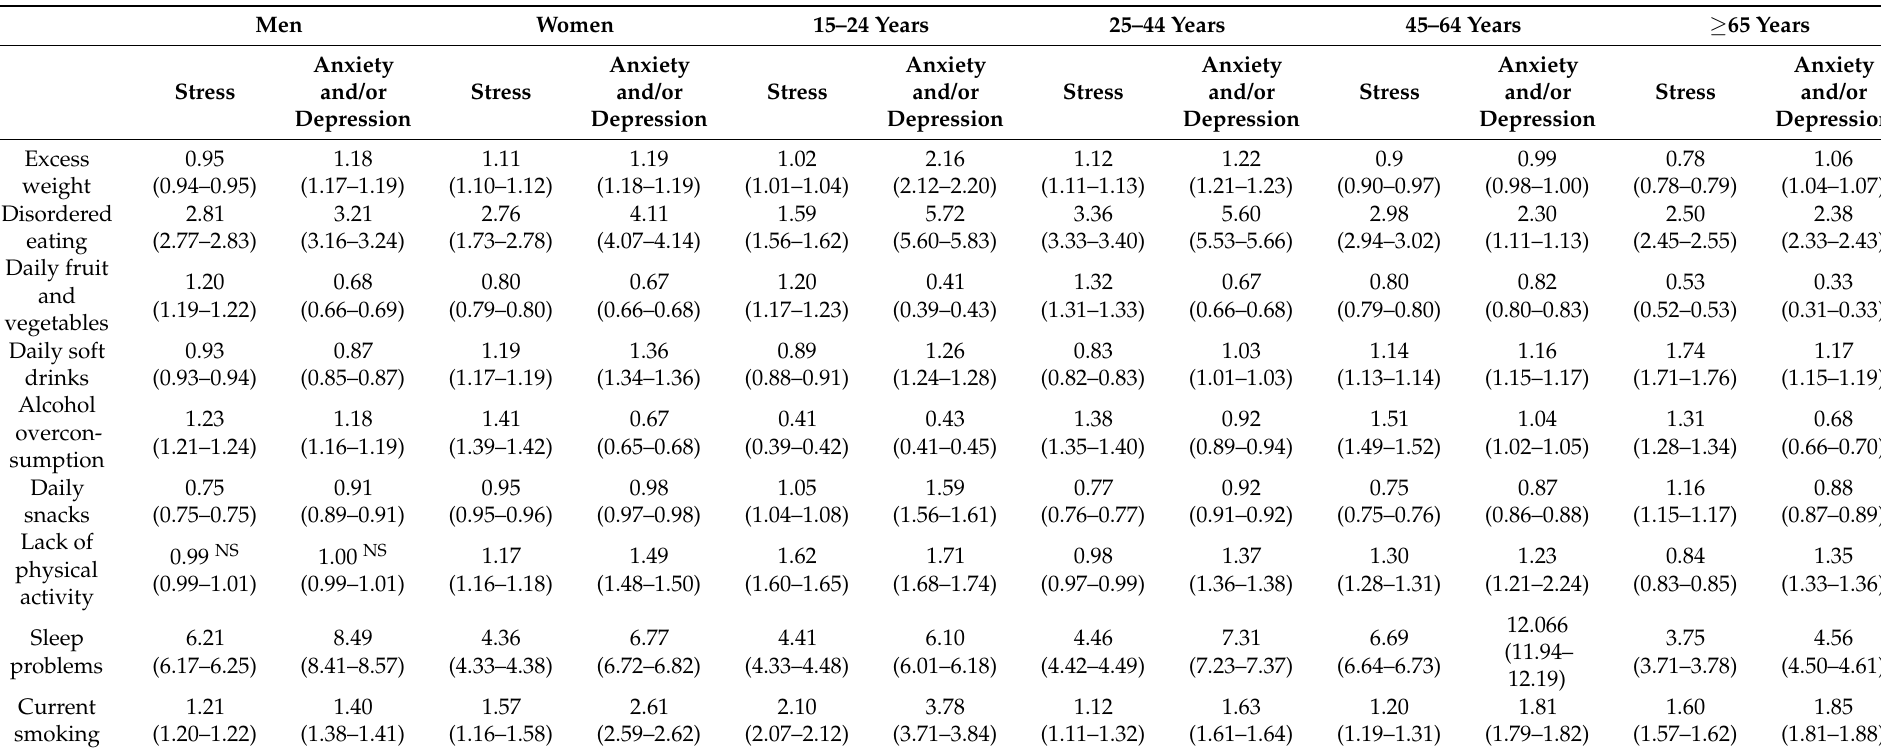
Table 2. Odds ratio for lifestyle factors and excess weight predicted by poor mental health (stress, anxiety, and/or depression), stratified by age and